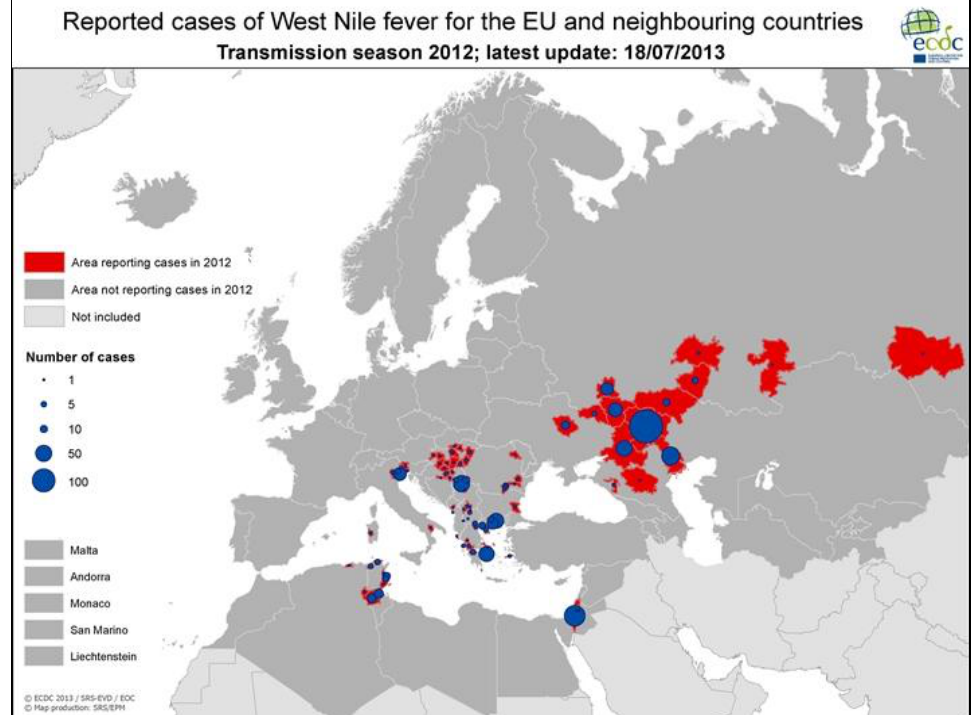
Figure 5. WNV human cases in EU and neighboring countries, 2012 (Source: